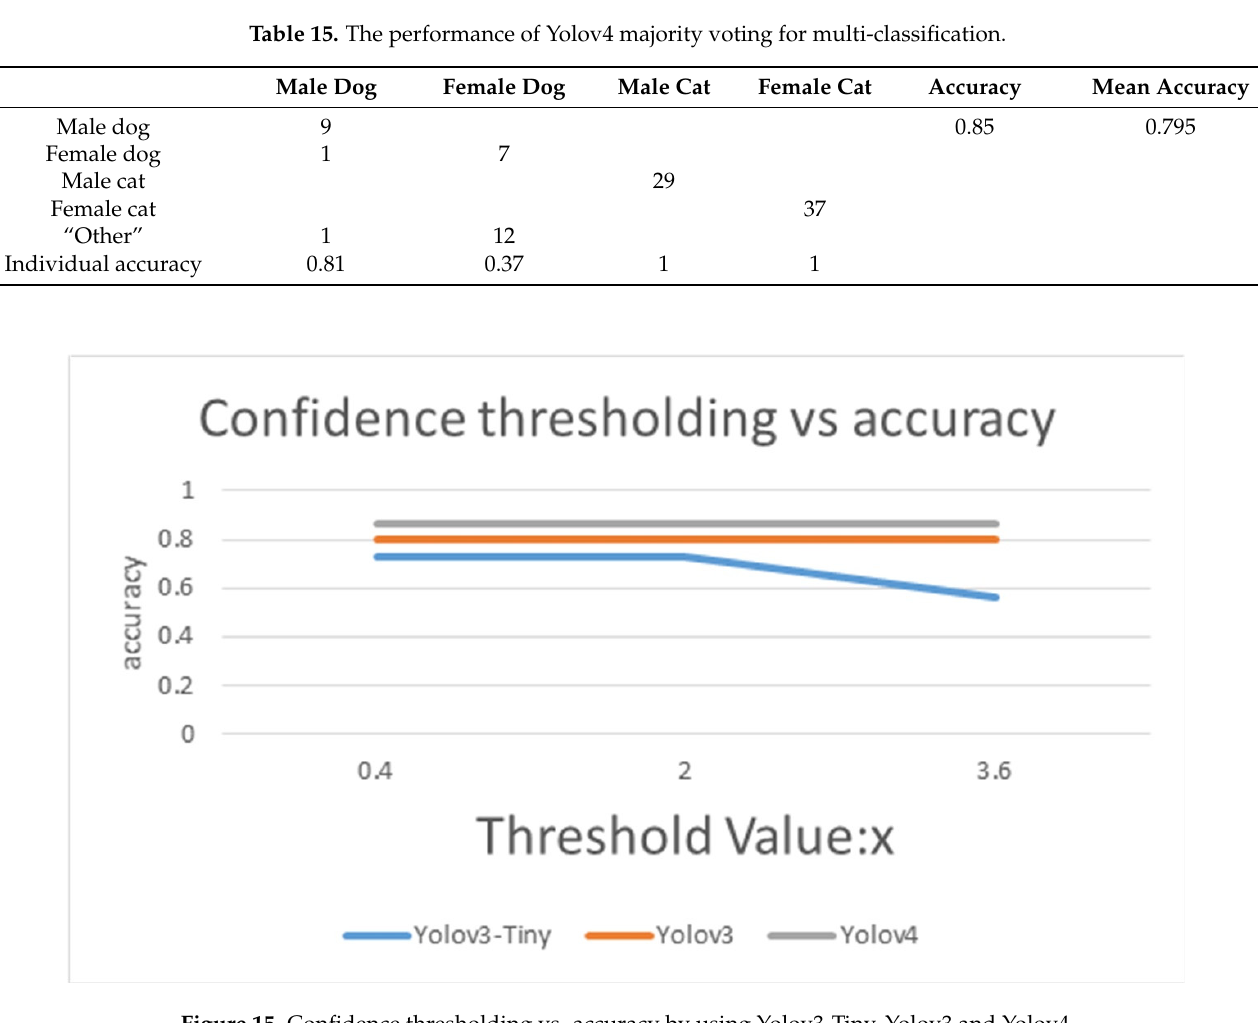
Figure 15. Confidence thresholding vs. accuracy by using Yolov3-Tiny, Yolov3 and Yolov4.